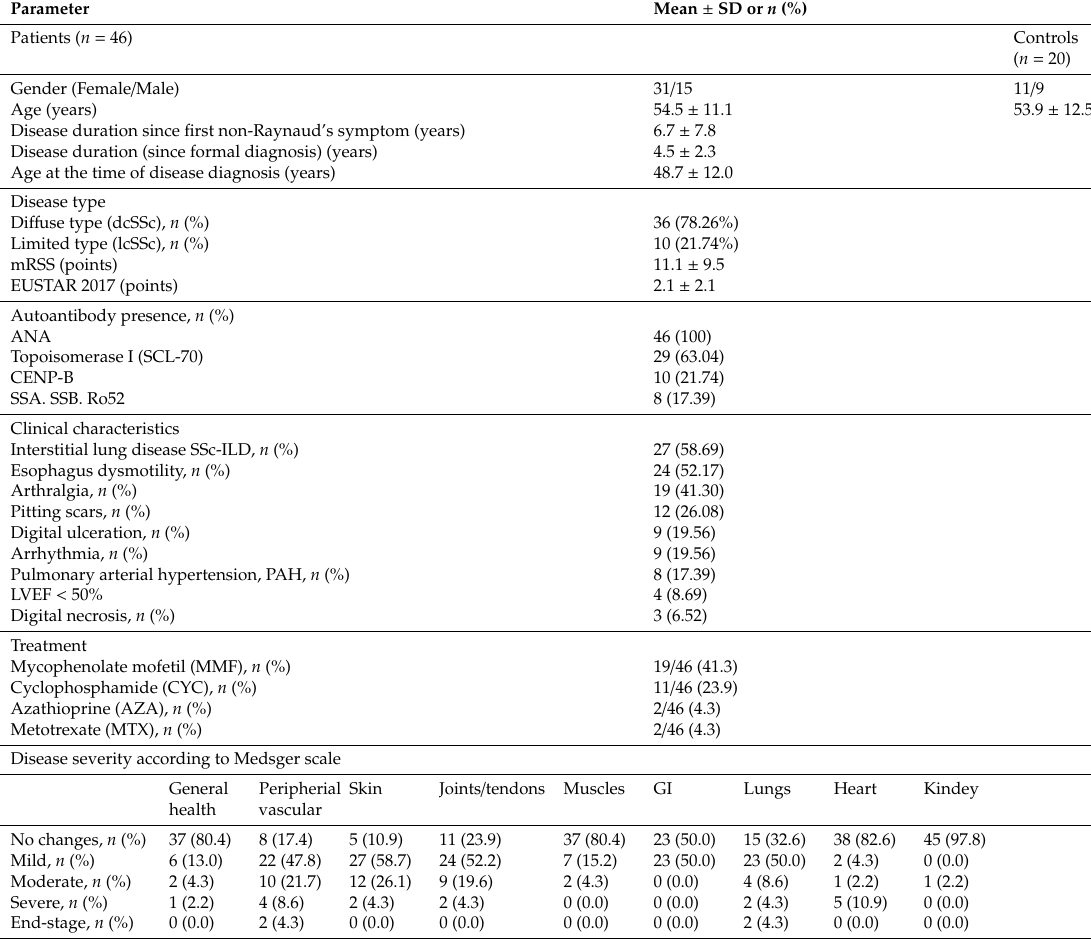
Table 1. Demographic characteristics, clinical severity, and disease damage in patients with SSc. Parameter Mean ± SD or n (%) Patients ( n =